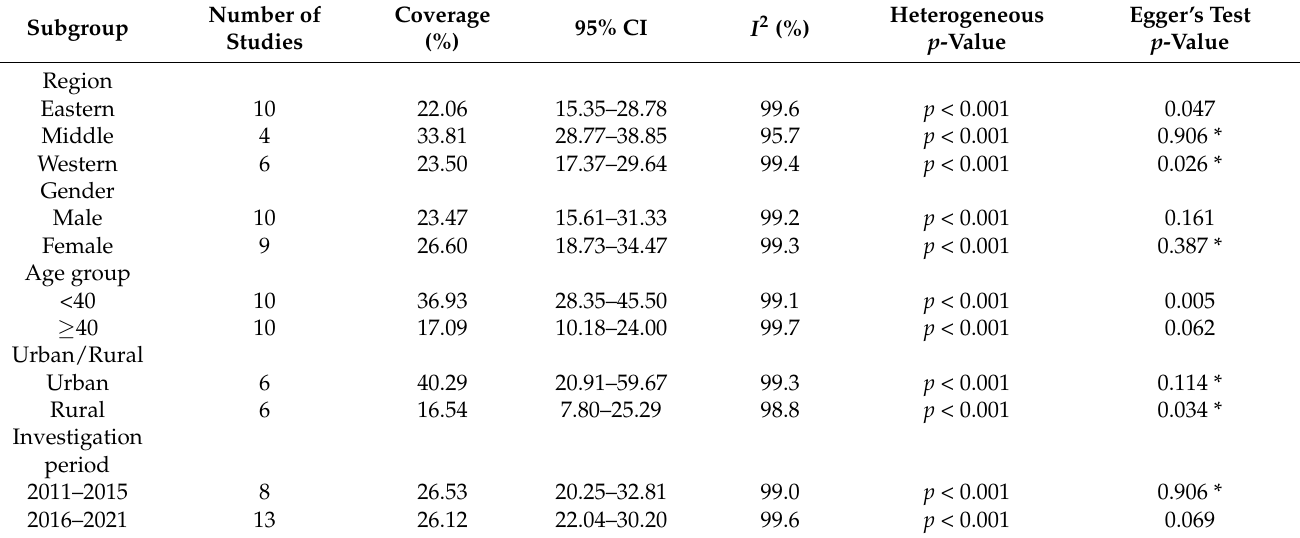
Table 2. Subgroup meta-analysis of studies reporting hepatitis B vaccination coverage in China from